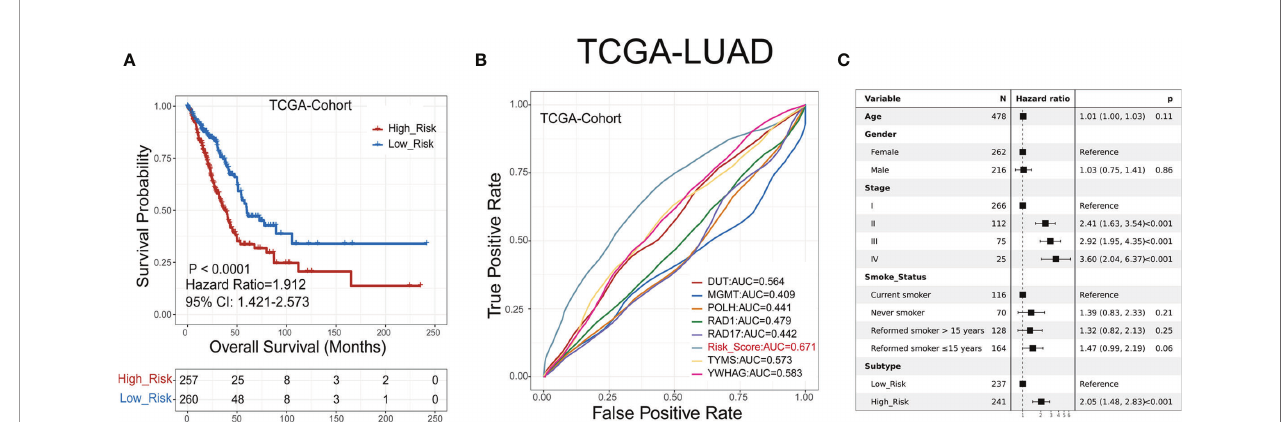
FIGURE 3 | GDPLichi score can function as a prognostic index for LUAD patients. (A) Kaplan-Meier plots of the survival probability for low- and high-risk subgroups of TCGA cohort, respectively. (B) ROC curves for the performance of the GDPLichi score as well as the seven risk genes of the classi fi er in TCGA in predicting prognosis. (C) Forest plot representation of multivariate Cox model depicting the association between overall survival and LUAD subgroups with other clinical factors considered in the TCGA